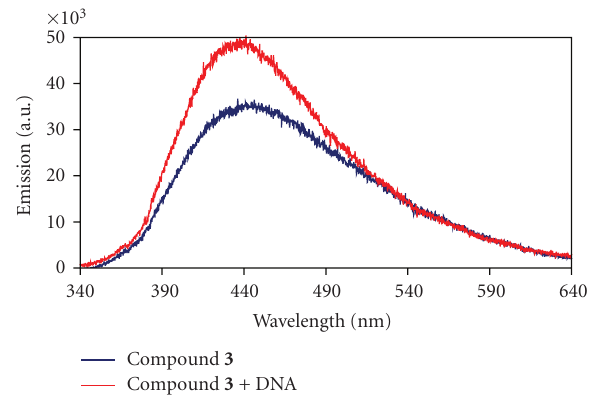
Figure 4: Emission spectrum of 3 (10 μ M) in phosphate bu ff er at pH 7. Blue: without DNA, Red: with 30 μ M/b.p of Calf thymus